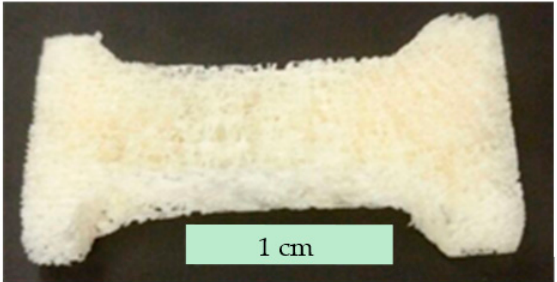
Figure 3. The machined demineralized bone graft prepared for a tensile test.